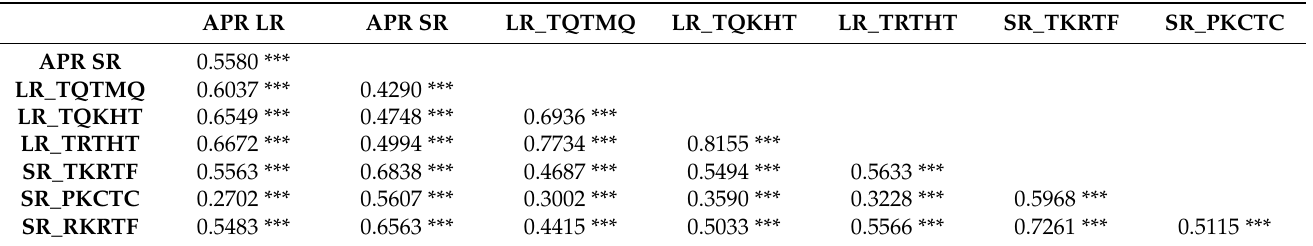
Table 2. Correlation among race-specific seedling resistance and adult plant resistance (APR) to leaf rust (LR) and stem rust (SR) in the studied